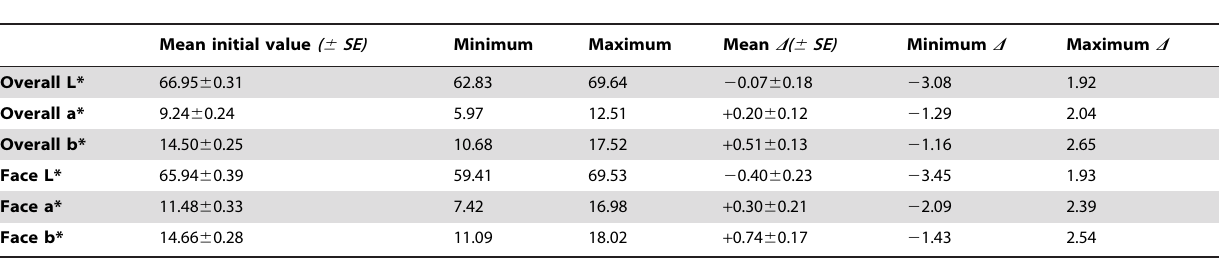
Table 1. Mean initial CIE L*a*b* values across 35 participants.